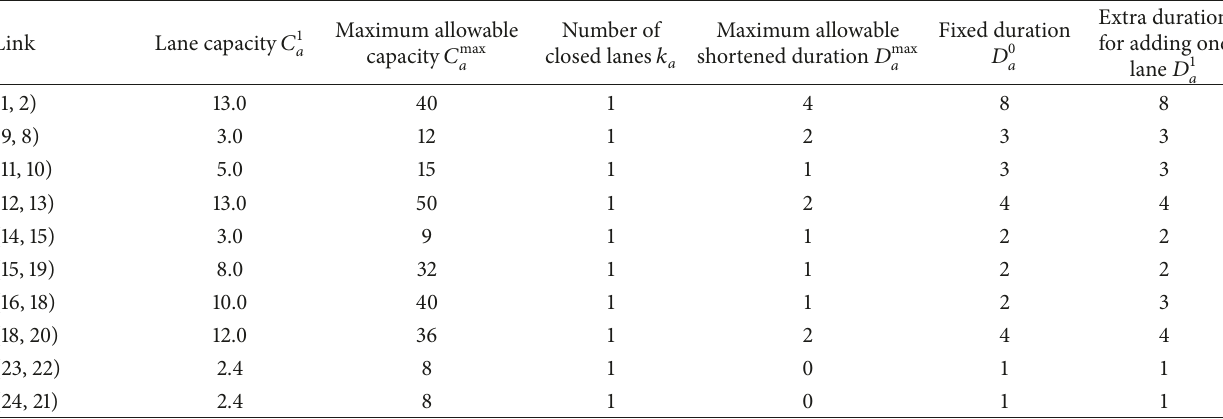
Table 5: Parameters for candidate projects in the Sioux Falls